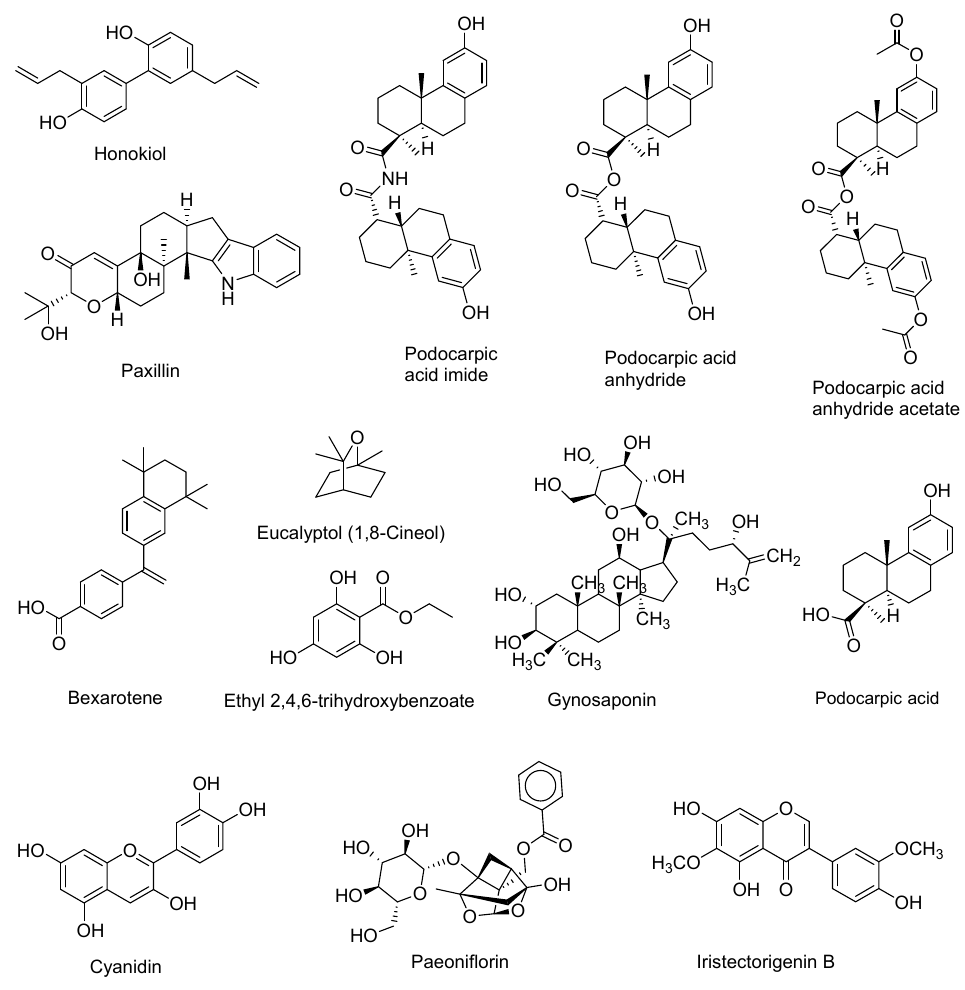
Figure 5. Structures of selected natural compounds as LXR ligands.